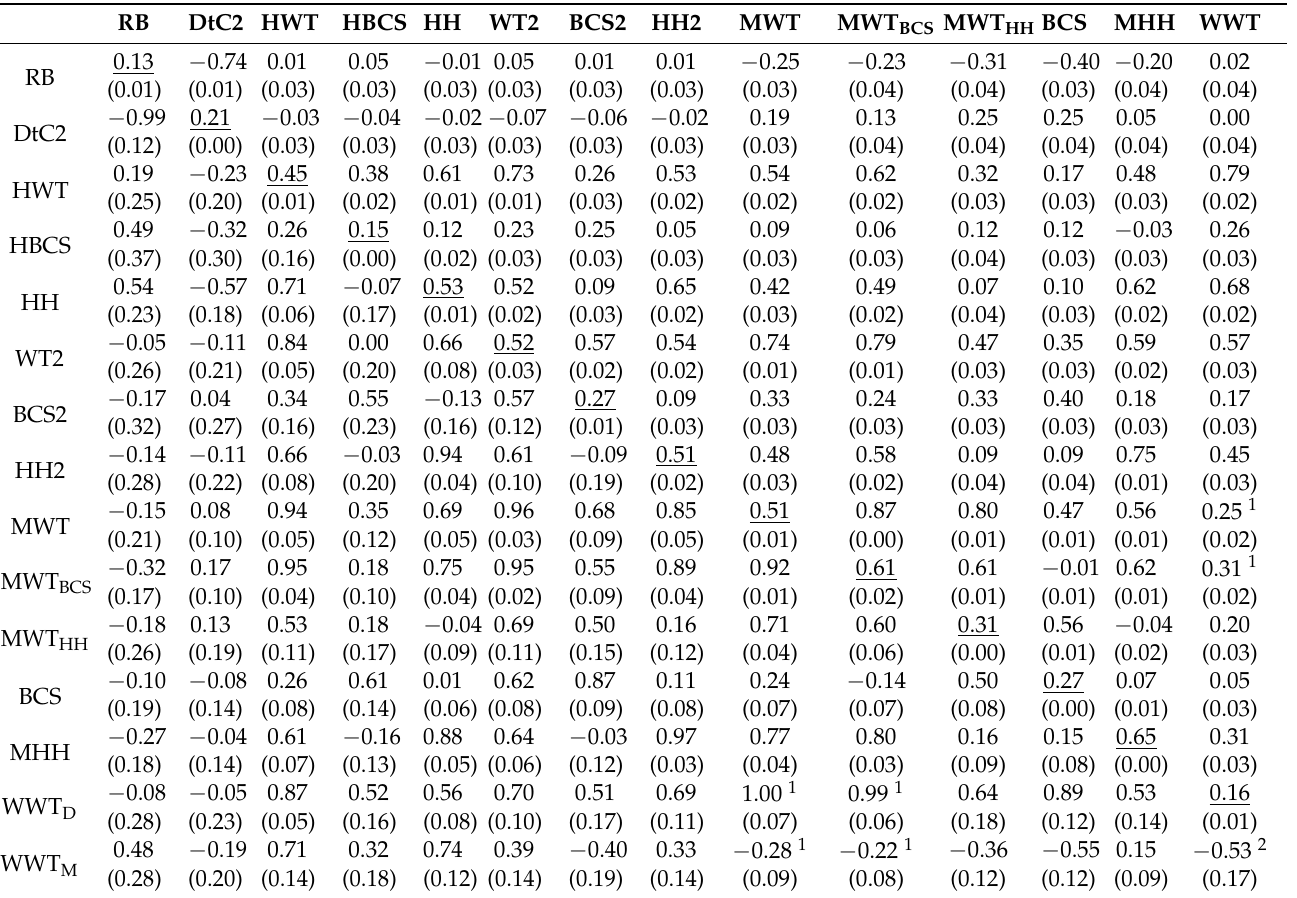
Table 5. Averaged heritabilities ( ± SEM, diagonal), genetic ( ± SE, below diagonal) and phenotypic ( ± SE, above diagonal) correlations from bivariate animal models among 15-month-old heifer, 2-year-old cow and mature cow traits in New Zealand beef